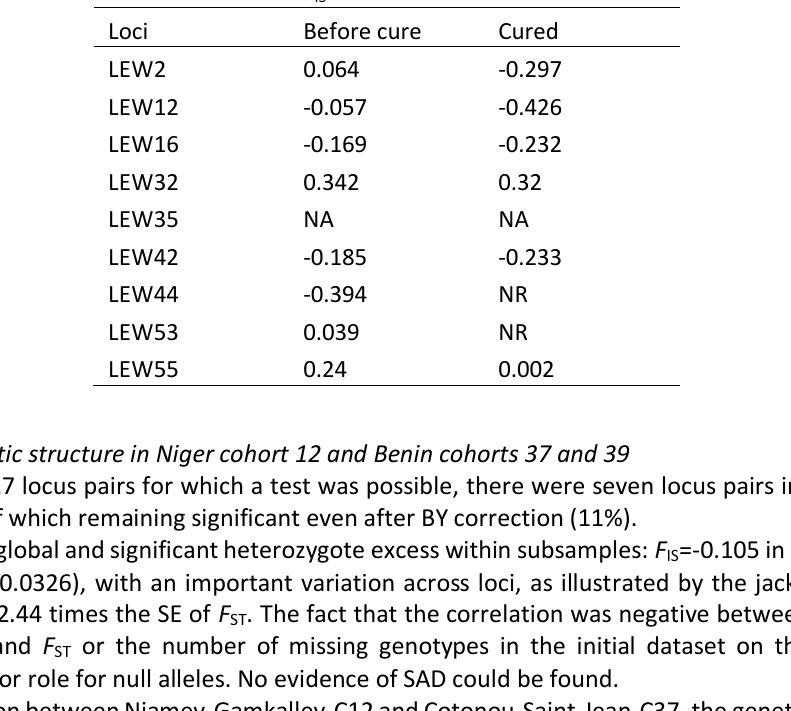
Table 4: Comparisons, for each locus, of the F IS before and after stuttering correction, except for loci for which cure was not relevant (NR) (i.e. loci with no suspicion of stuttering). NA: not available (monomorphic locus in the subsamples studied). See text for details F IS Loci Before cure Cured LEW2